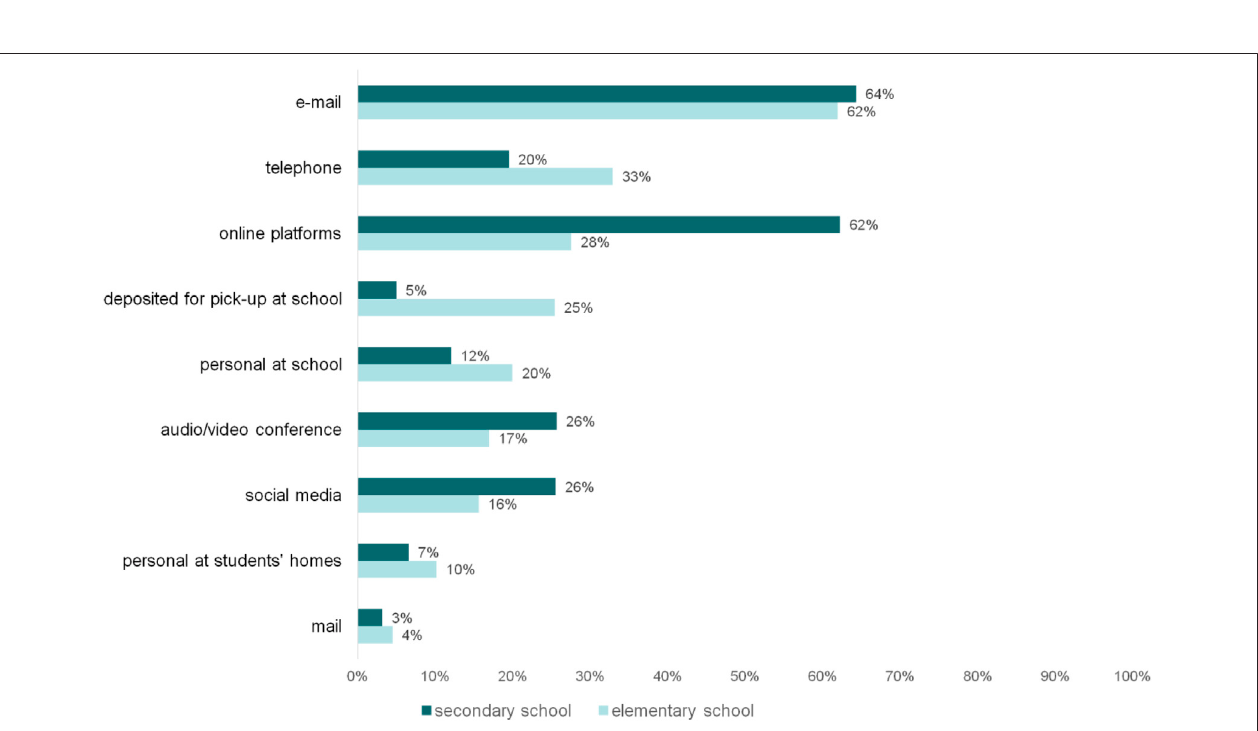
Frontiers in Education |